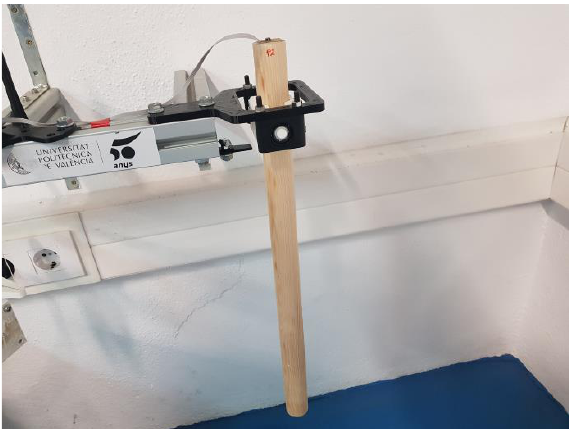
Figure 13. One of the references used to calibrate vertical MOI test stand.